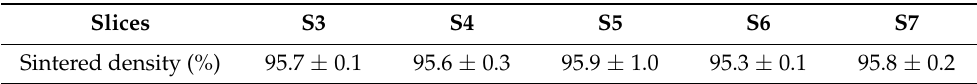
Figure 7. ( a ) Representative engineering stress-strain curves and ( b ) a summary of tensile mechanical properties for slices cut from different positions of the sintered cylinder. Table 1. Sintered density in terms of percentage of theoretical density for slices taken from the large